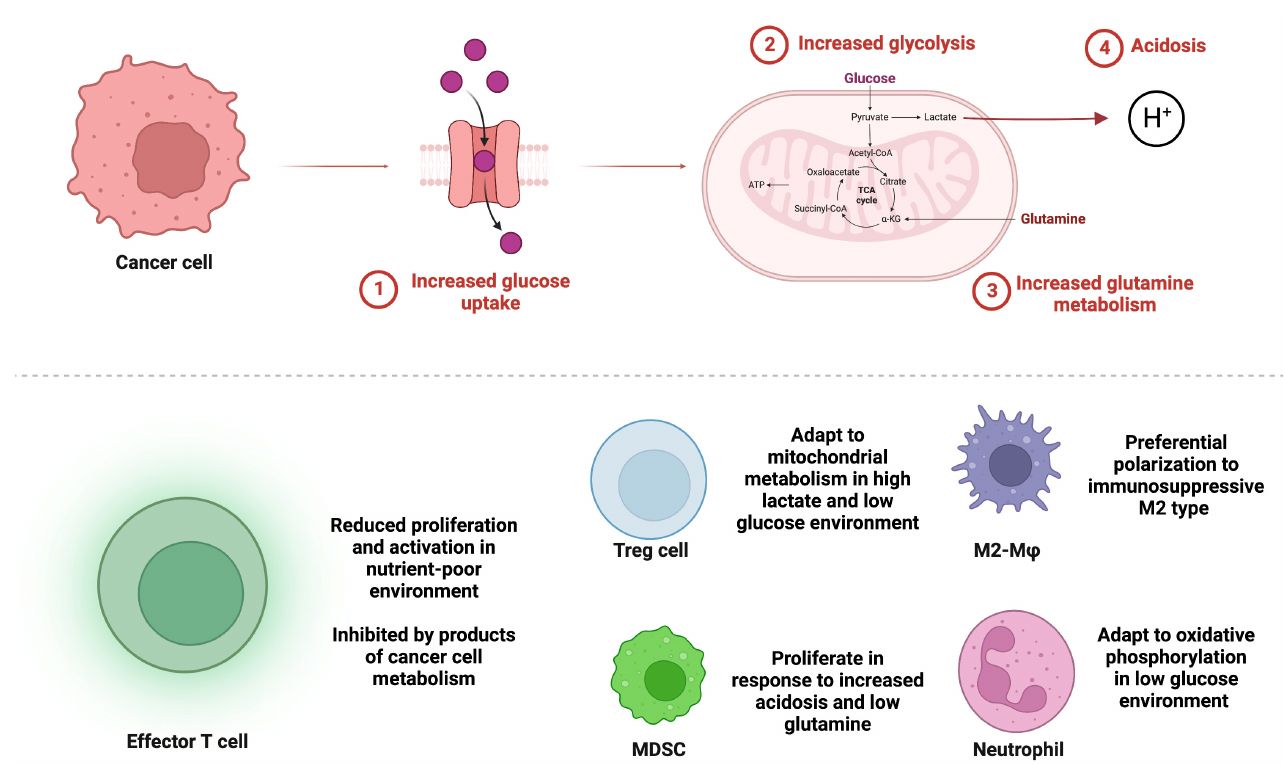
Figure 1. Glucose and glutamine metabolism in cancer cells alters immune cell populations in the glioblastoma tumor microenvironment. ( Top ) Cancer cells up regulate glucose transport into the cell ( 1 ) and increase glycolytic ( 2 ) and glutamine metabolism ( 3 ) leading to low levels of glucose and glutamine in the tumor microenvironment. Increased glycolysis results in acidosis from increased lactic acid production ( 4 ). ( Bottom ) Immune cell populations respond differentially to metabolic alterations in the tumor microenvironment. Anti-tumoral effector T cells have reduced function and proliferation. Pro-tumoral immunosuppressive populations of Tregs, MDSCs, M2 polarized macrophages, and neutrophils are enriched.